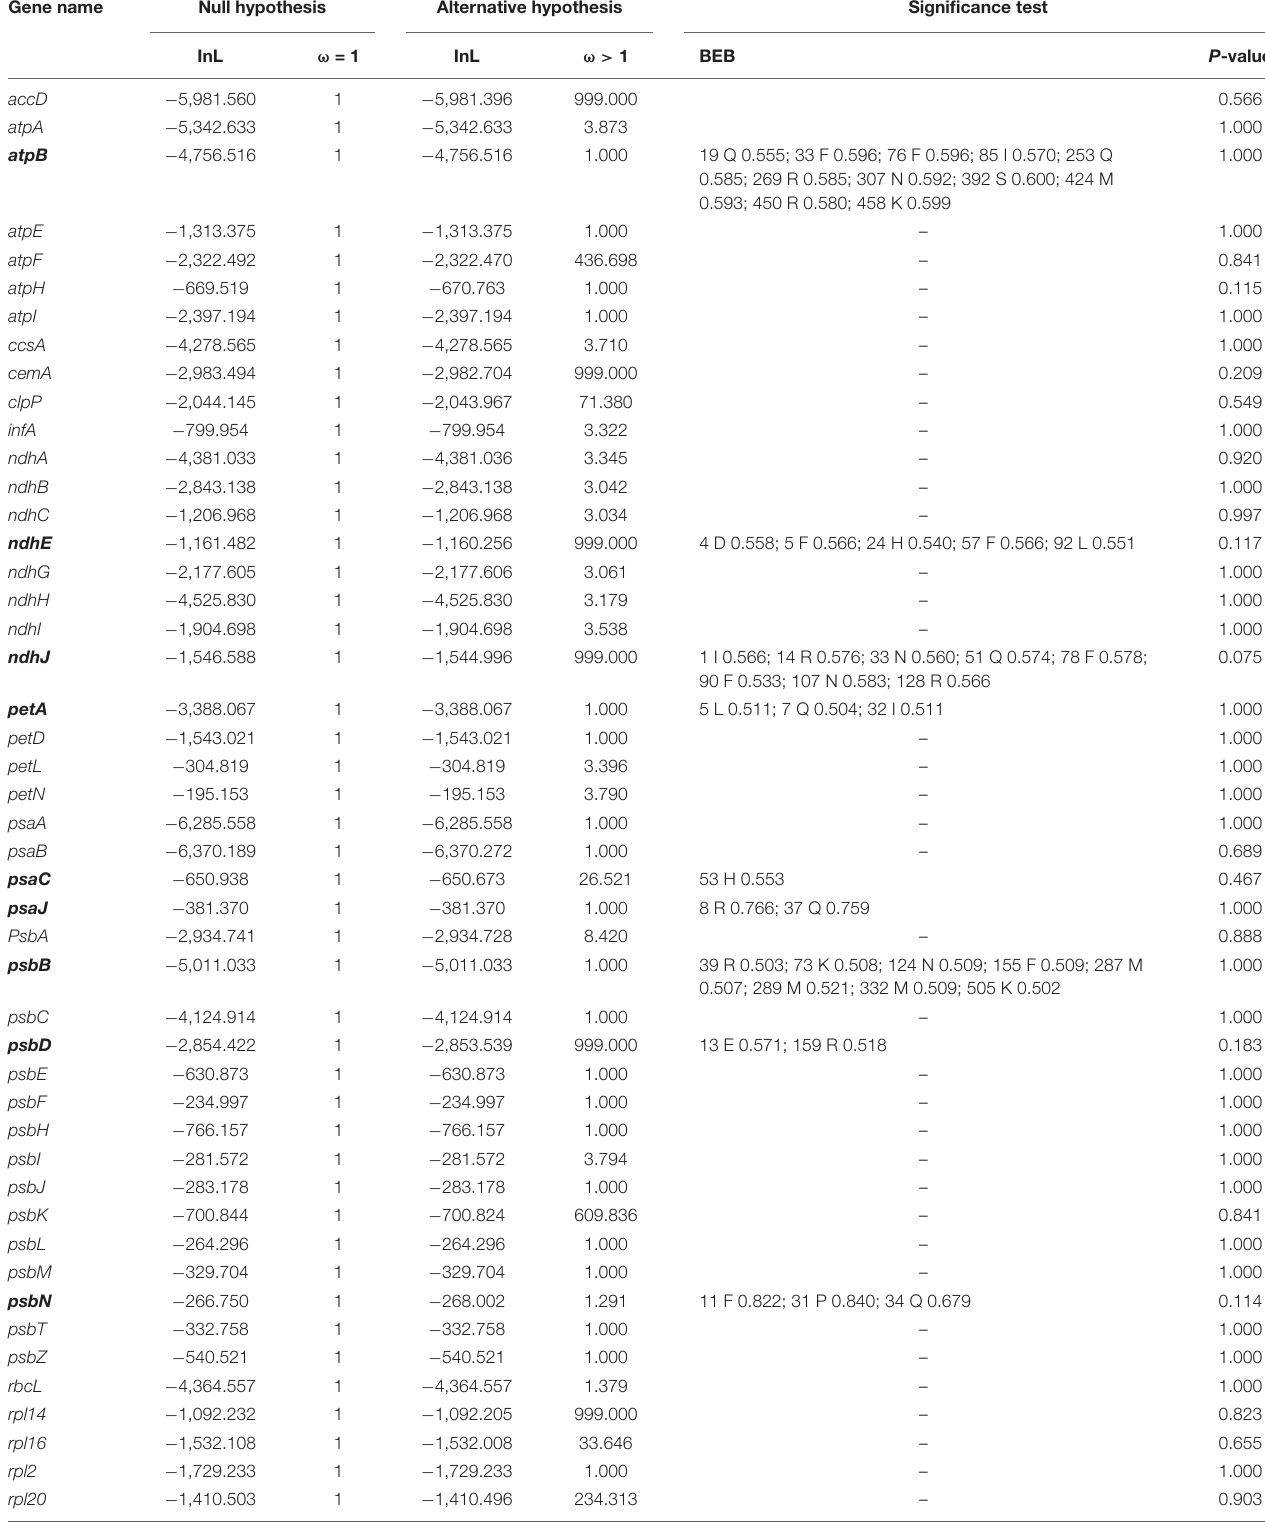
TABLE 2 | The positive selection test based on the branch-site